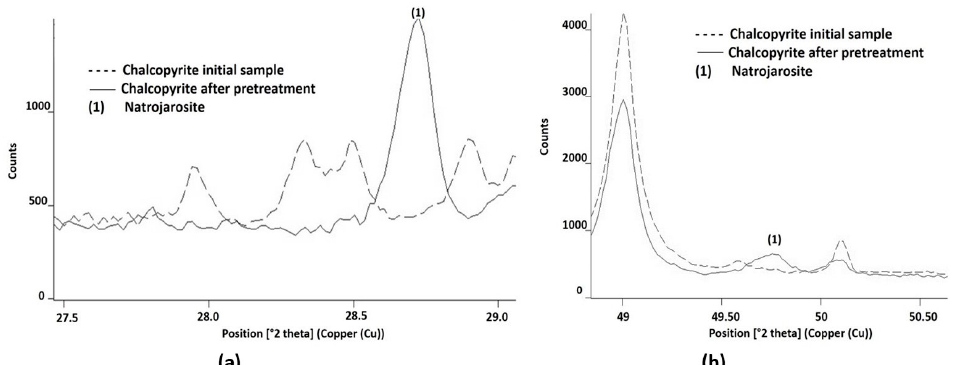
Figure 9. NaFe 3 (SO 4 ) 2 (OH) 6 identified by X-ray diffraction, a product of the pretreatment of chalco- pyrite mineral with 15 kg/t of H 2 SO 4 , 25 kg/t of NaCl, and 15 days of curing at room temperature. In ( a , b ) the new presence of NaFe 3 (SO 4 ) 2 (OH) 6 was identified as (1), compared with the initial dif- fractogram of the sample.